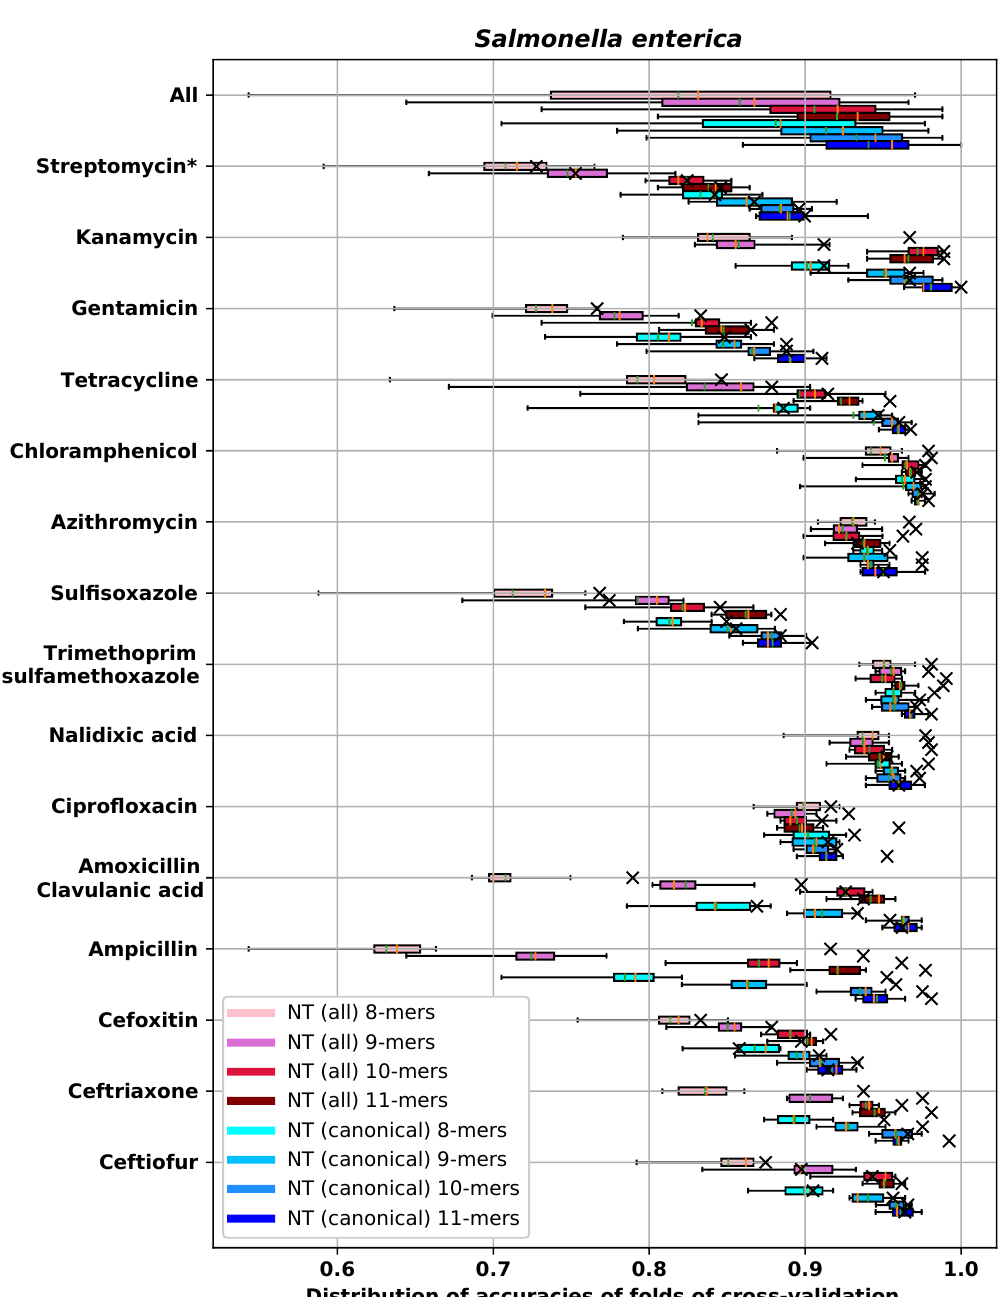
Figure A11. Distribution of accuracies in different nucleotide k -mers for S. enterica . Plots are similar to Figure